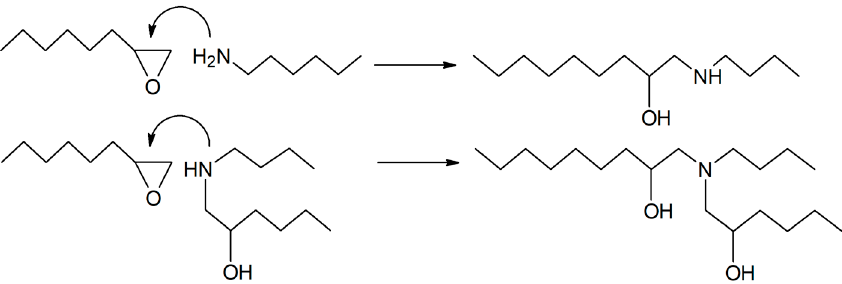
Figure 2. Simplified scheme of the epoxy-amine condensation mechanism. Table 1. Percentages in weight of epoxy monomers and crosslinking agent used in the preparation of the formulations.